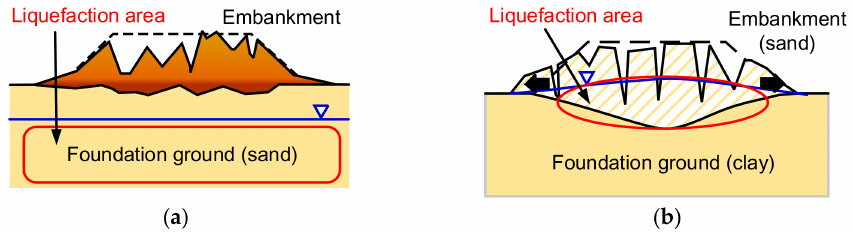
Figure 1. Damage mechanism of embankments due to liquefaction; ( a ) liquefaction occurring in foundation, ( b ) liquefaction occurring in